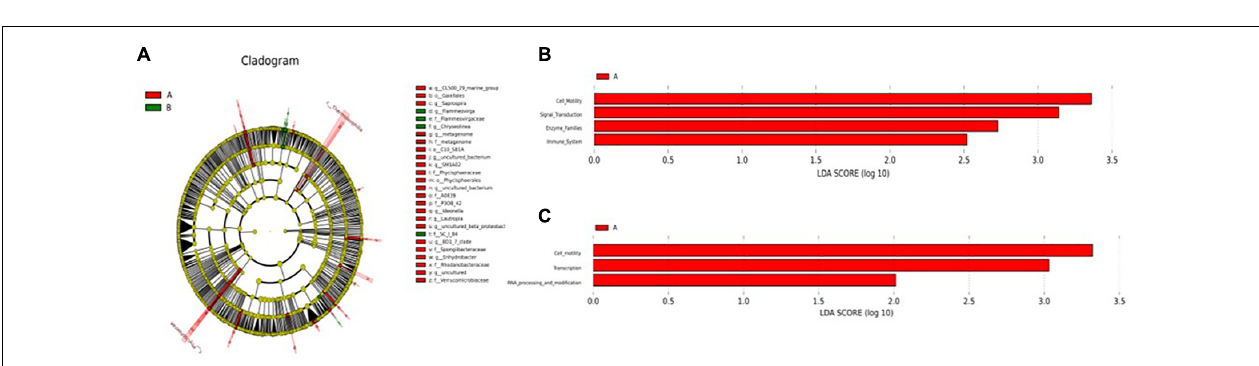
FIGURE 2 | (A) Cladogram showing significant overrepresentation of microbial populations and taxa as assessed by linear discriminant analysis effect size (LEfSe) ( P ≤ 0.05 and linear discriminant analysis (LDA) cutoff > 3.0). (B) Microbial functional predictions revealed the most differentially regulated metabolic pathways in the fecal microbiome at KEGG level. (C) Microbial functional predictions revealed the most differentially regulated metabolic pathways in the fecal microbiome at the clusters of orthologous groups (COG) level.